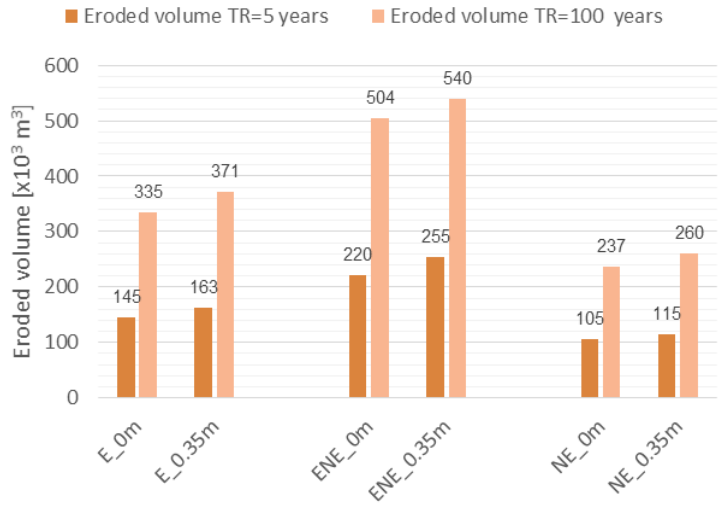
Figure 12. Sediment eroded volumes corresponding to present climate scenarios for each of the studied combinations of storm direction, return period and sea level (legend: [storm direction] _ [sea level]).